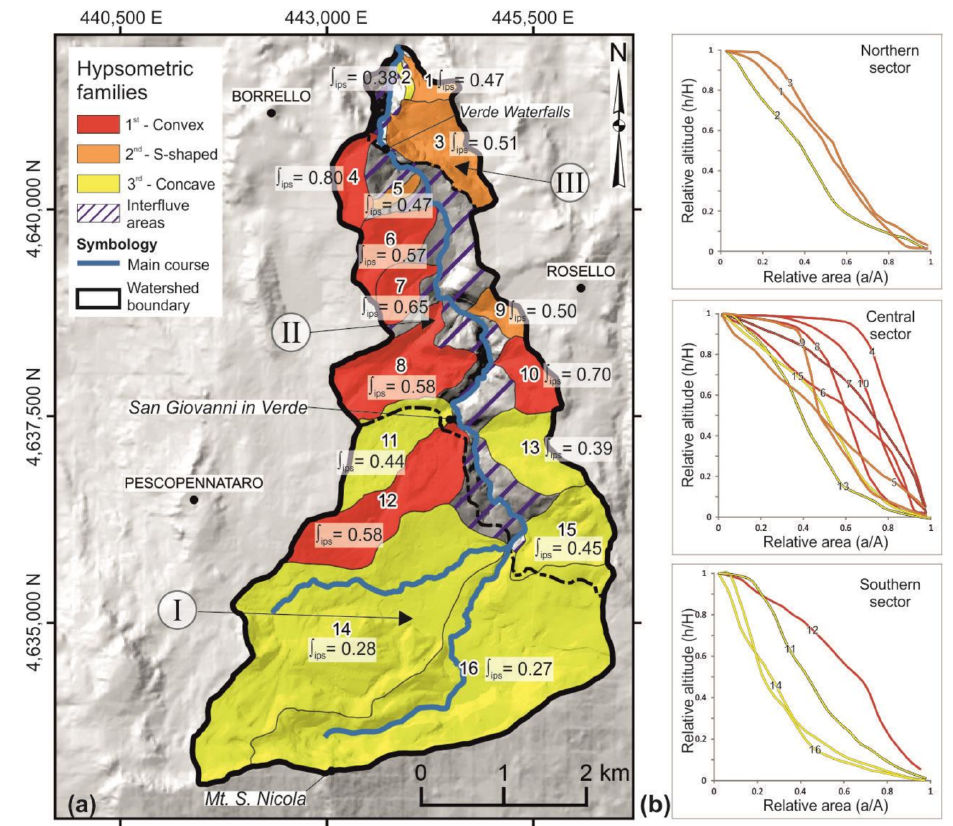
Figure 8. ( a ) Hypsometric families map (numbers refer to the drainage sub-basin). The dashed black line indicates the orographic sector boundary (numbers I, II, III). ( b ) Hypsometric curves of each orographic sector; in red: convex shaped curves belong to the first hypsometric family; in orange: S-shaped curves belong to the second hypsometric family; in yellow: concave shaped curves belong to the third hypsometric